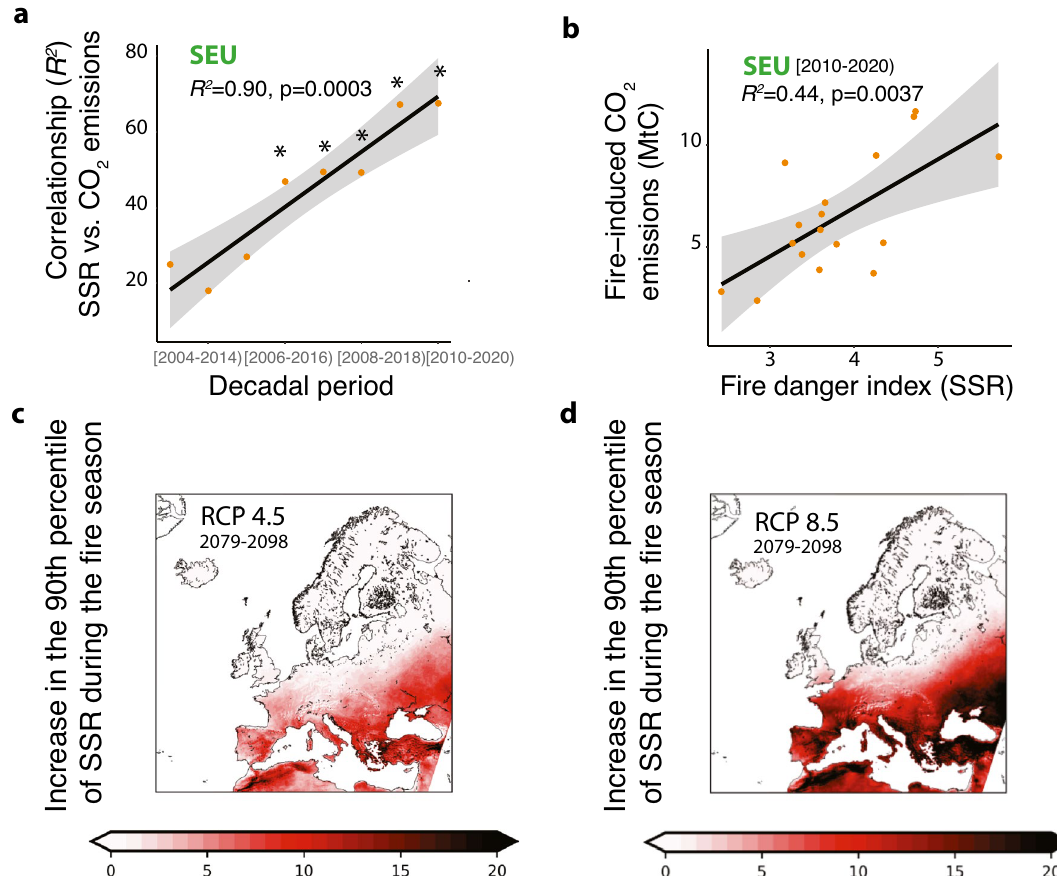
Figure 2. Observed changes in the non-stationary relationships between fire weather danger (SSR) and fire impacts (CO 2 emissions, MtC) in Southern Europe. ( a ) Changes in the explained variation ( R 2 ) observed in moving-window correlation analyses over the last two decades (2000–2020). Asterisks in panel a (*) indicate significant correlationships, observed only in the last decade. ( b ) Observed relationship between Seasonal Severity Rating index (SSR) and satellite-estimated fire-induced CO 2 emissions in the last decade. ( c ) Projected increase in the 90th percentile of SSR during the fire season predicted for the 2079–2098 time period under RCP 4.5. SSR increases are represented relative to the values estimated for the reference period (1986–2005, Fig. S4). ( d ) Projected increase in the 90th percentile of SSR under RCP 8.5. Maps were produced using Python Programming Language version 3.8 (see